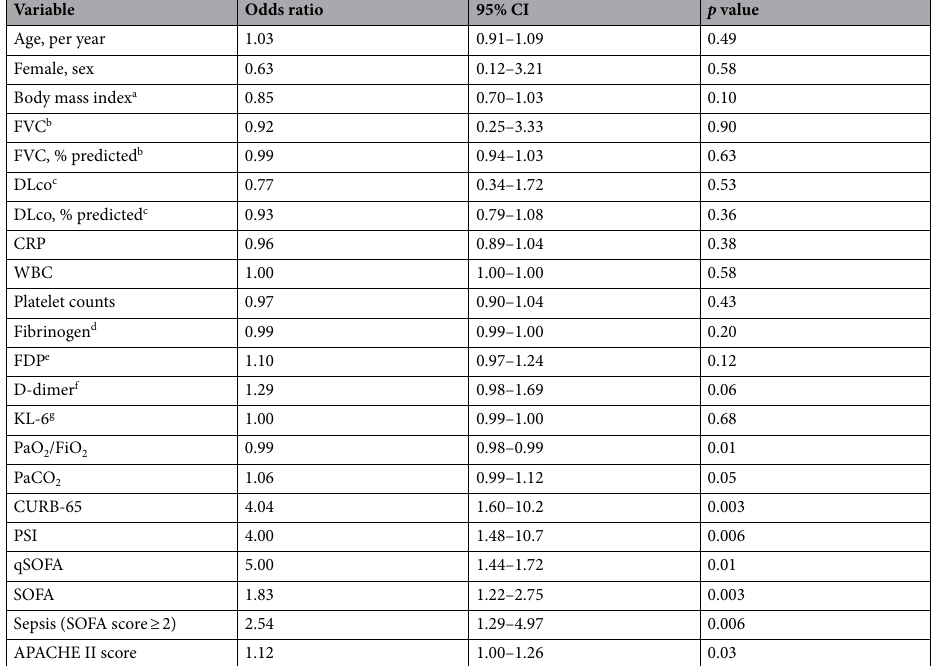
Table 3. Results of the univariate logistic regression analysis of hospital mortality (n = 79). APACHE II Acute Physiology and Chronic Health Evaluation II; CURB-65 confusion, urea, respiratory rate, blood pressure and age; CRP C reactive protein; DLco diffusing capacity for carbon monoxide; FDP fibrinogen and fibrin degradation products; FVC forced vital capacity; KL-6 Krebs von der Lungen-6; PaCO 2 partial pressure of carbon dioxide; PaO 2 /FiO 2 partial pressure of arterial oxygen / fraction of inspiratory oxygen; PSI Pneumonia Severity Index; qSOFA quick Sequential Organ Failure Assessment; SOFA sequential organ failure assessment;